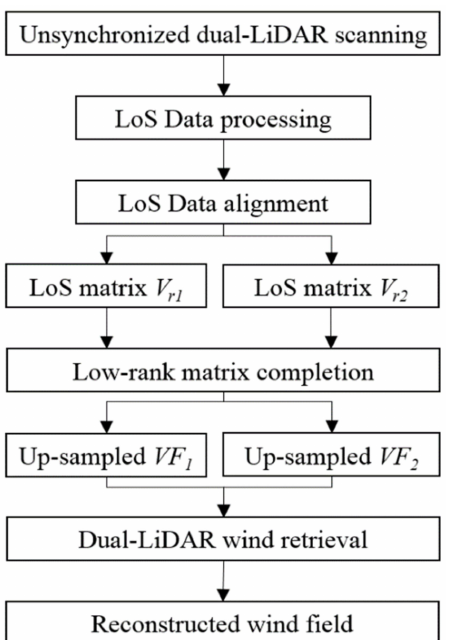
Figure 5. The flowchart of the time-resolved dual-LiDAR imaging system.